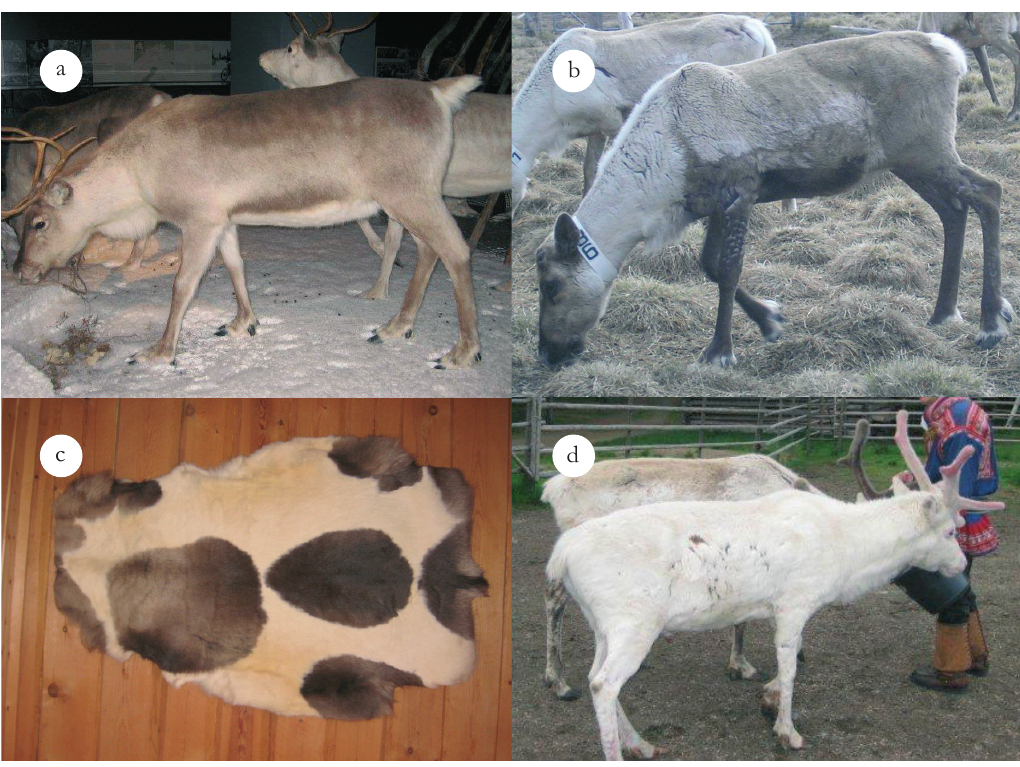
Fig. 1a-d. Adult colour phenotype induced by dif- ferent alleles 1